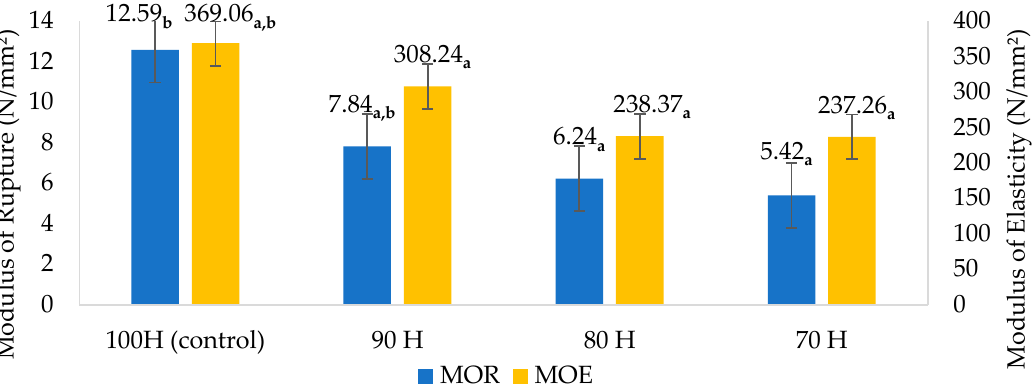
Figure 5. Average MOE and MOR values of WPC with different alphabets (a, and b) displayed beside the average values show significant differences among the parameters.